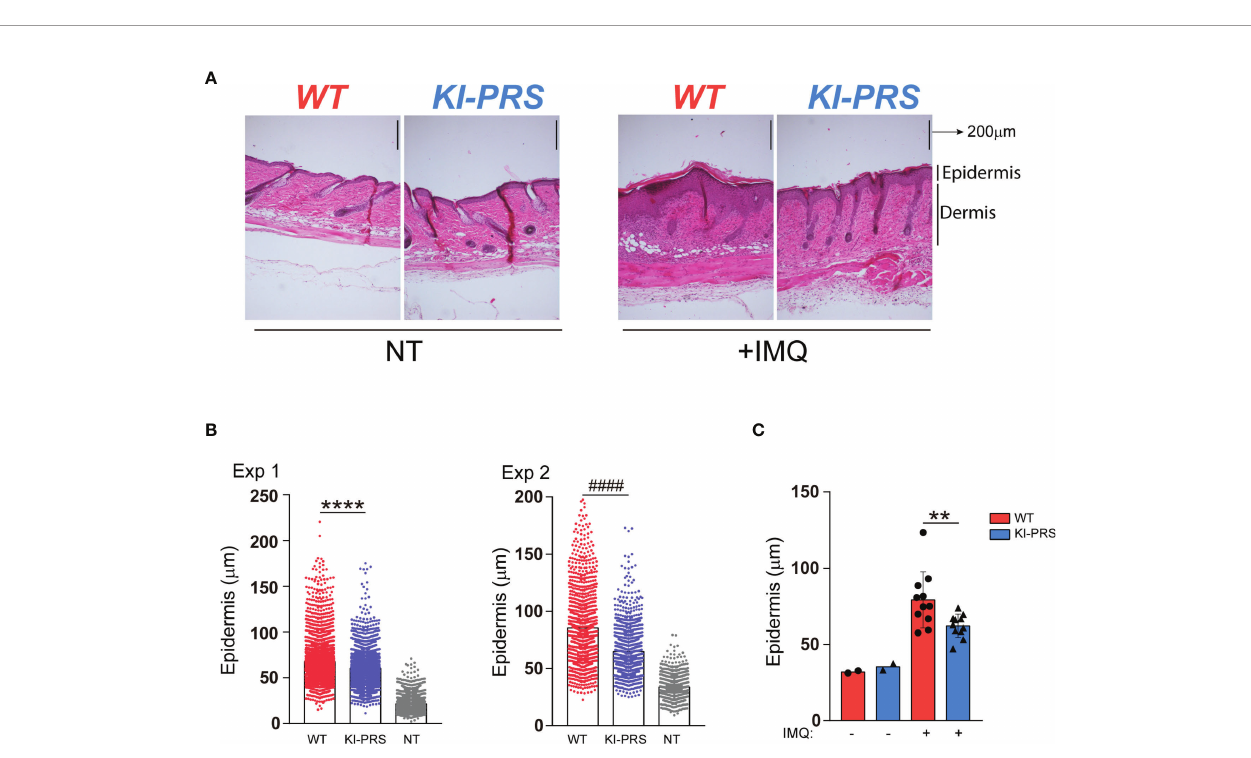
FIGURE 4 | Formation of IMQ-induced psoriasis-like lesions is ameliorated in KI-PRS mice. KI-PRS and WT littermates were treated with Imiquimod (IMQ) for 7 days on ears and shaved backs, or left untreated (NT). On day 7, back skin sections were subjected to hematoxylin and eosin (H/E) staining for microscopy analysis. The thickness of the epidermal layer was measured at multiple sections and sites, randomly chosen in a blind manner. (A) Representative sections of H/E staining in the indicated conditions. Dermal and epidermal layers are indicated on the right. (B) Graphs represent all individual measurements of the epidermal layer thickness in 2 independent experiments. Each dot represents a single measure (8 sections per mouse, 32 measures per section). In experiment number 1, n= 5 treated mice from each genotype and n= 2 WT untreated mice were used (****p-value< 0.0001). In experiment 2, n= 6 treated mice from each genotype and n=4 untreated WT animals were used ( #### p-value< 0.0001). (C) Graph represents the epidermis thickness (mean ± sd). Each dot represents the thickness measurement per mouse (averaged value of 8 sections per mouse, 32 measures per section) from both experiments (n=11, **p-value= 0.0083). Statistical analysis was performed using Mann-Whitney t-test.